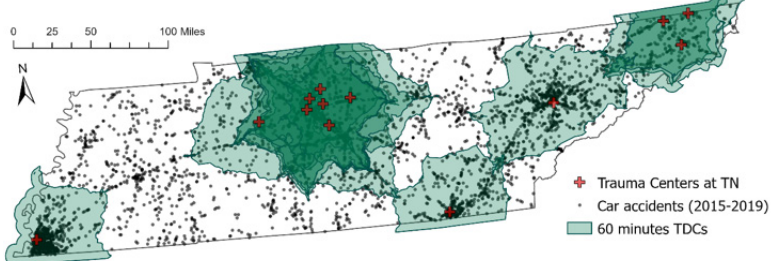
Figure 4. The 60 min TDCs from existing trauma centers and locations of vehicle accidents.